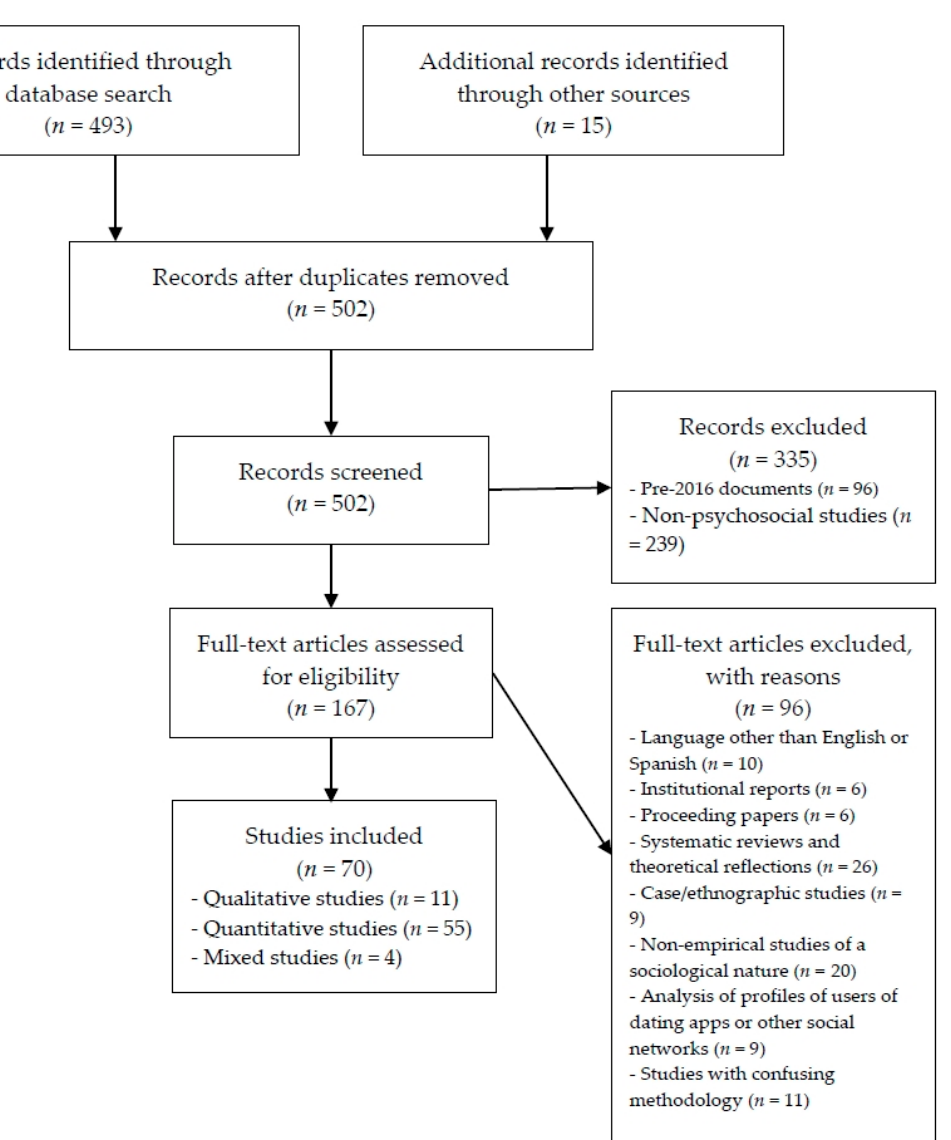
Figure 1. Flowchart of the systematic review process.